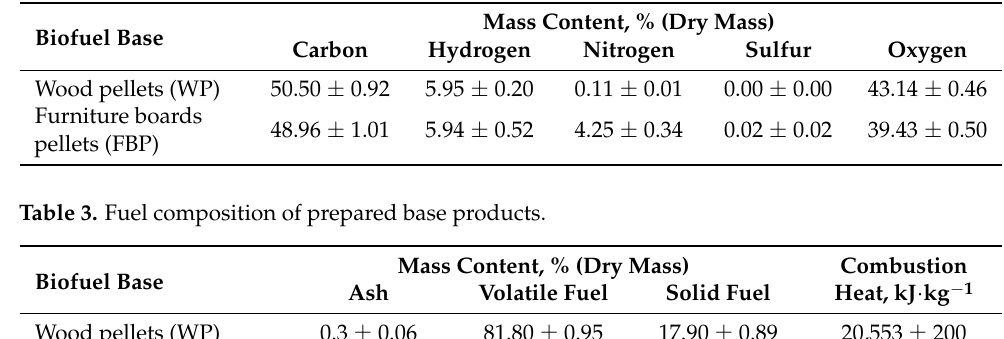
Table 2. Elemental composition of prepared base products.